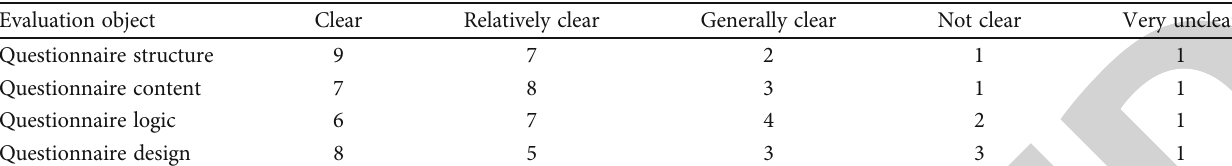
Table 7: Questionnaire validity test.